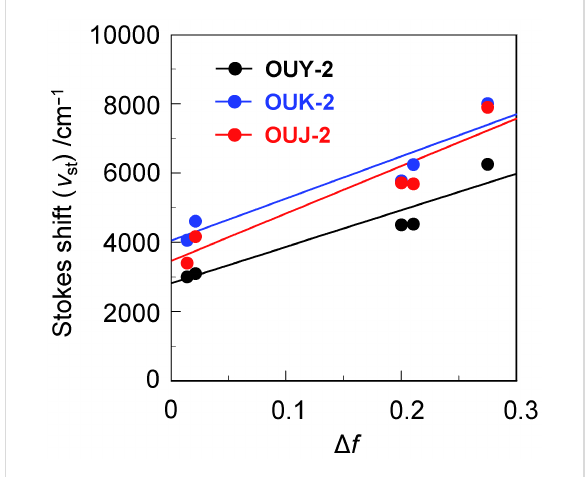
Figure 3: Correlation of the Stokes shift ( ν st ) and the orientation polar- izability ( Δ f ) according to Equation 1 and Equation 2, respectively, for OUY-2 , OUK-2 and OUJ-2 ; solvent ( ε , n , Δ f ): toluene (2.38, 1.4969, 0.0132), 1,4-dioxane (2.21, 1.4224, 0.0205), ethyl acetate (6.02,